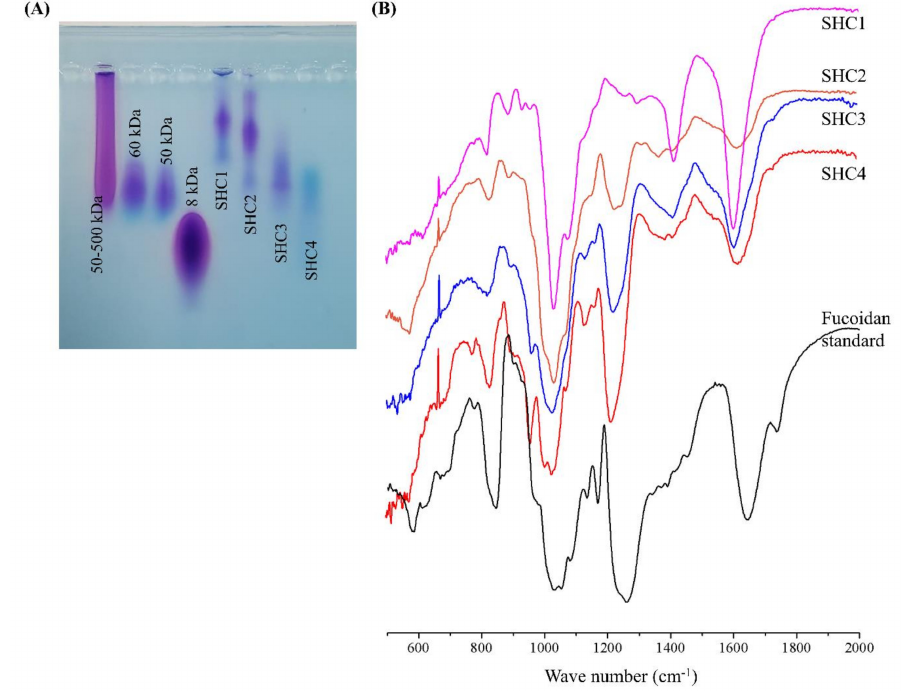
Figure 2. Characterization of polysaccharide fractions (SHC1–SHC4) obtained by step gradient ethanol precipitation. ( A ) Molecular weights (MW) distribution analysis of polysaccharide fractions compared to 50–500-kDa, 60-kDa, 50-kDa and 8-kDa MW standards and ( B ) vibrational spectra of polysaccharide fractions compared to commercial fucoidan